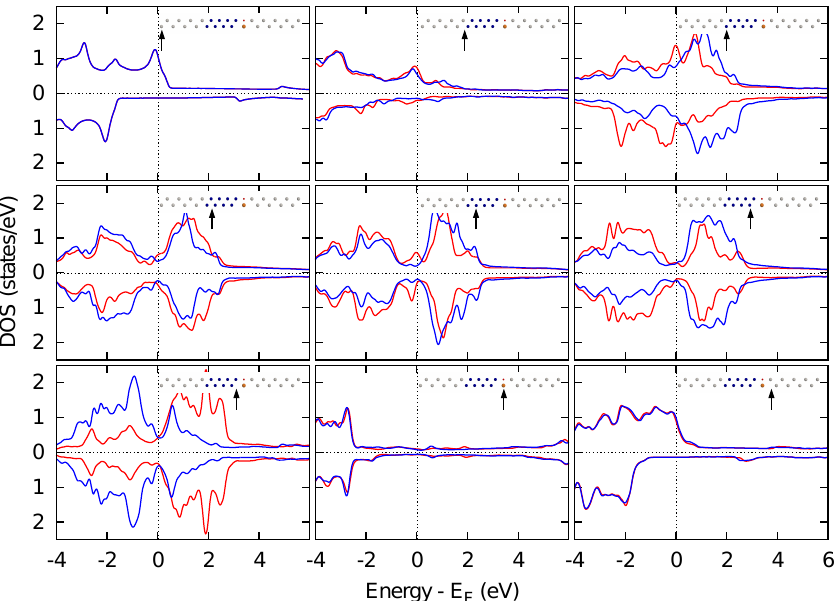
Figure 8. Spin resolved projected DOSs of asymmetric devices. The majority components are traced in red, and the minority components in blue. In each panel, the upper DOSs correspond to the Pt/Cr/MgO/Pt device, and the lower DOSs to the Au/Cr/MgO/Au one. Each panel reports the projection of the total DOS on a selected atomic layer, indicated by a black